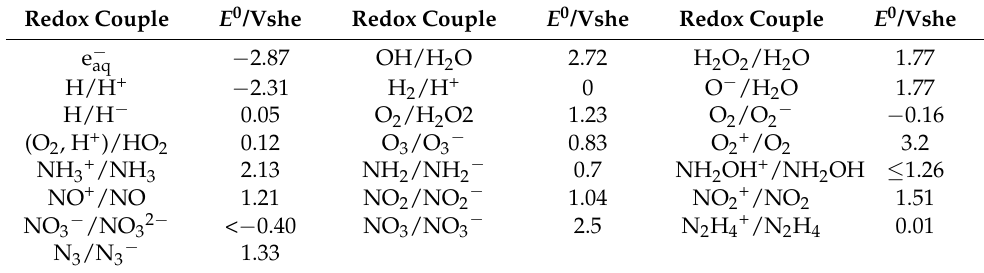
Table 8. Selected standard redox potentials for selected radicals [274]. Redox